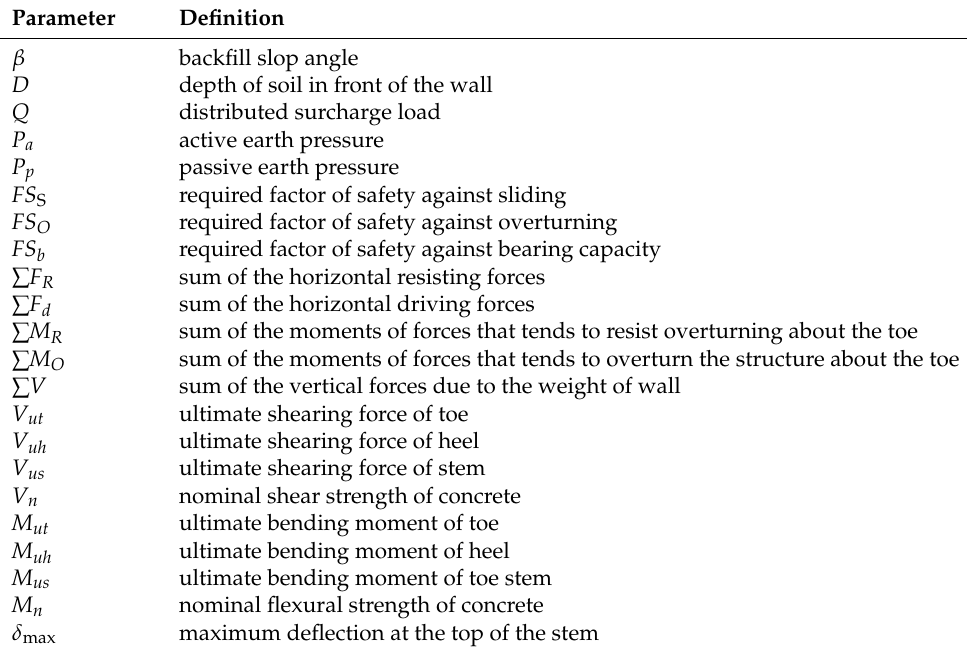
Table 12. Definition of parameters of Figure 6 and Table